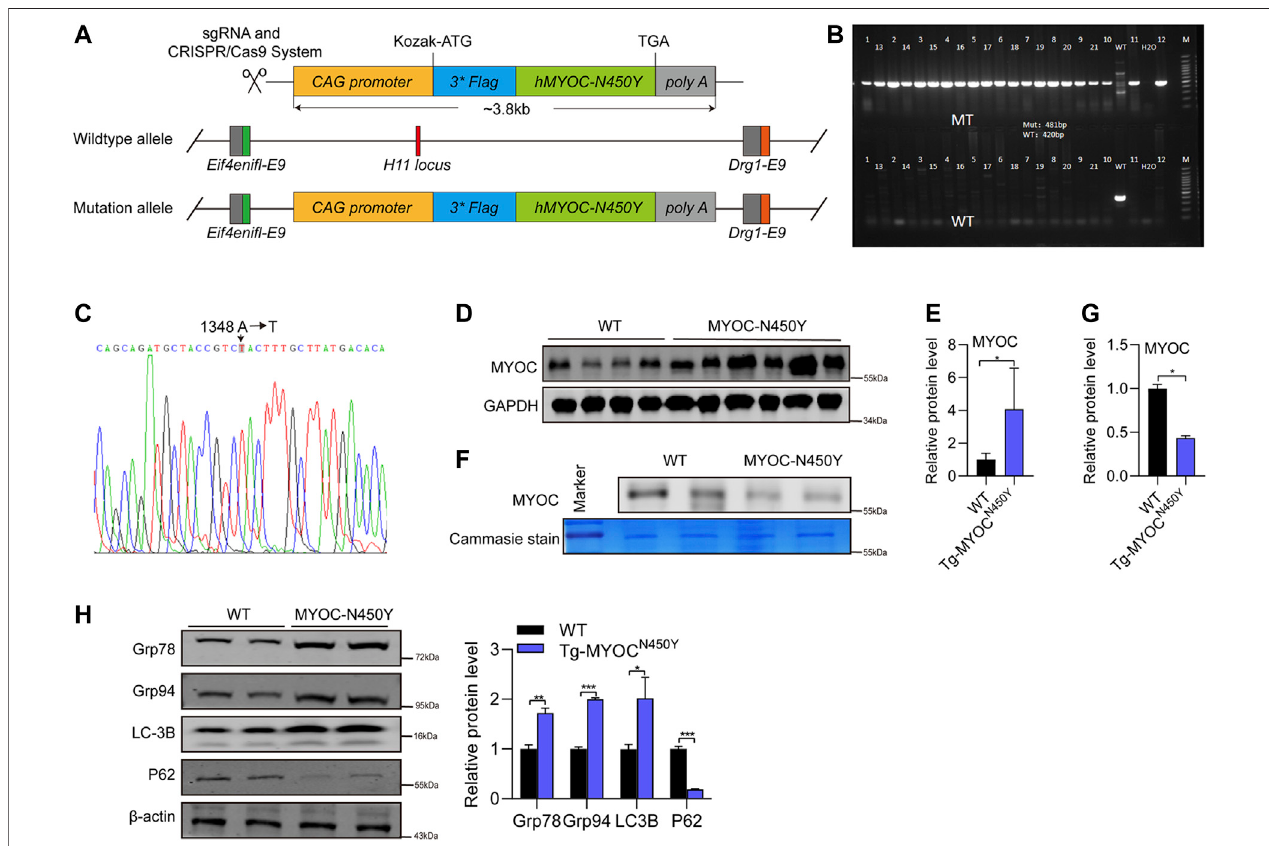
FIGURE4| MutantMYOC protein wasexpressed intheanterior angle ofTg-MYOC N450Y mice (A) Schematic ofTg-MYOCN450Yconstruct. (B) PCRwasapplied todetecttheexpressionoftransgeneMYOC-N450YinTg-MYOCN450Ymiceatageof5months. (C) ThepresenceofMYOC-N450Ywascon fi rmedbysequencing. (D) Western blot was used to analyse the MYOC expression in anterior chamber angle tissue in WT littermates and Tg-MYOC N450Y mice at 5 months of age. (E) Band intensityanalysisin (D) usingImageJsoftware.*,p < 0.05. (F) WesternblotwasusedtoanalysisMYOCsecretioninaqueoushumor.ns,nosigni fi cance;*,p < 0.05. (G) Band intensity analysis in (F) using ImageJ software. *, p < 0.05. (H) Western blot was used to analyse the expression of Grp78, Grp94, LC3B, p62 and GAPDH at 8 months of age in WT littermates and Tg-MYOCN450Y